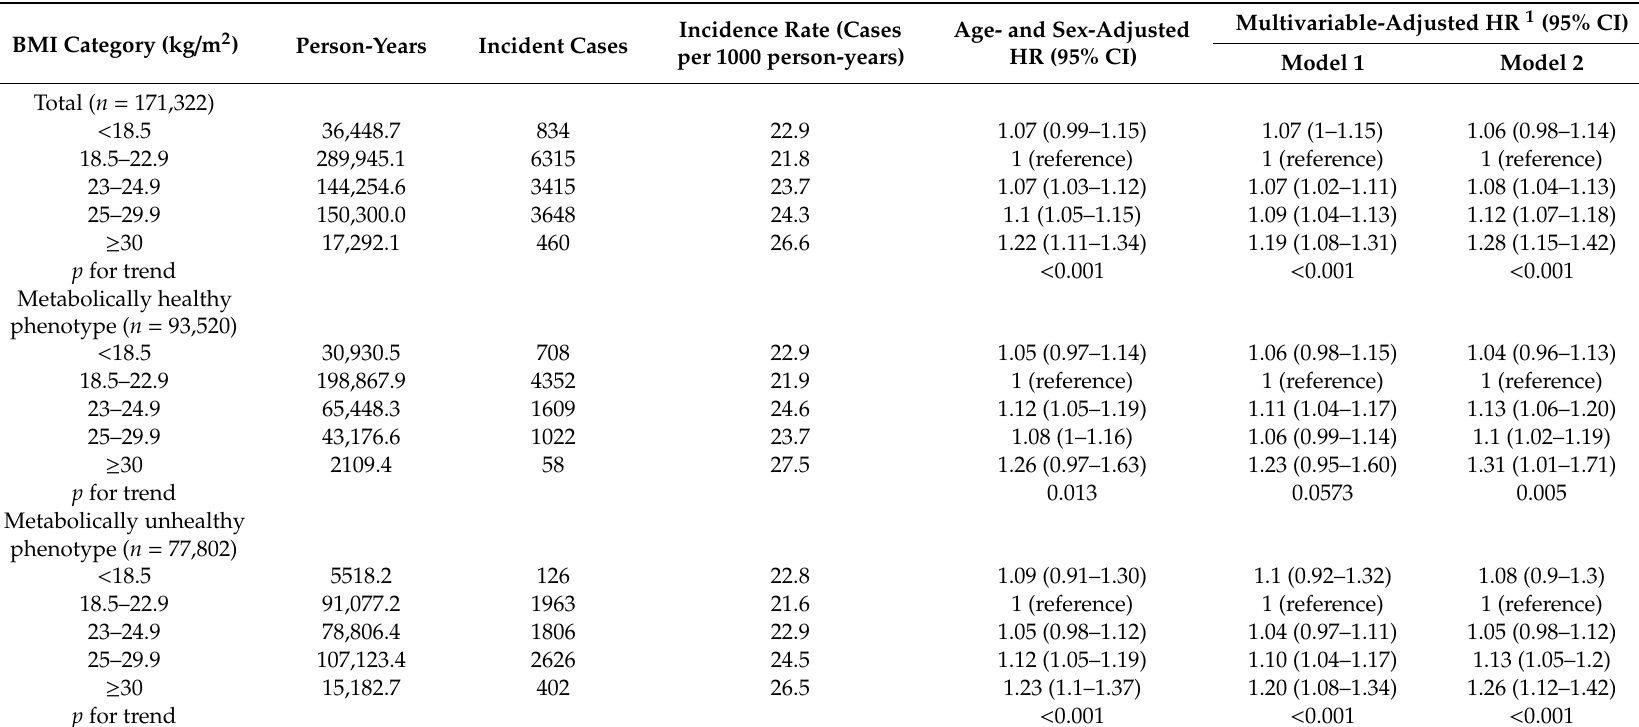
p for trend < 0.001 < 0.001 <